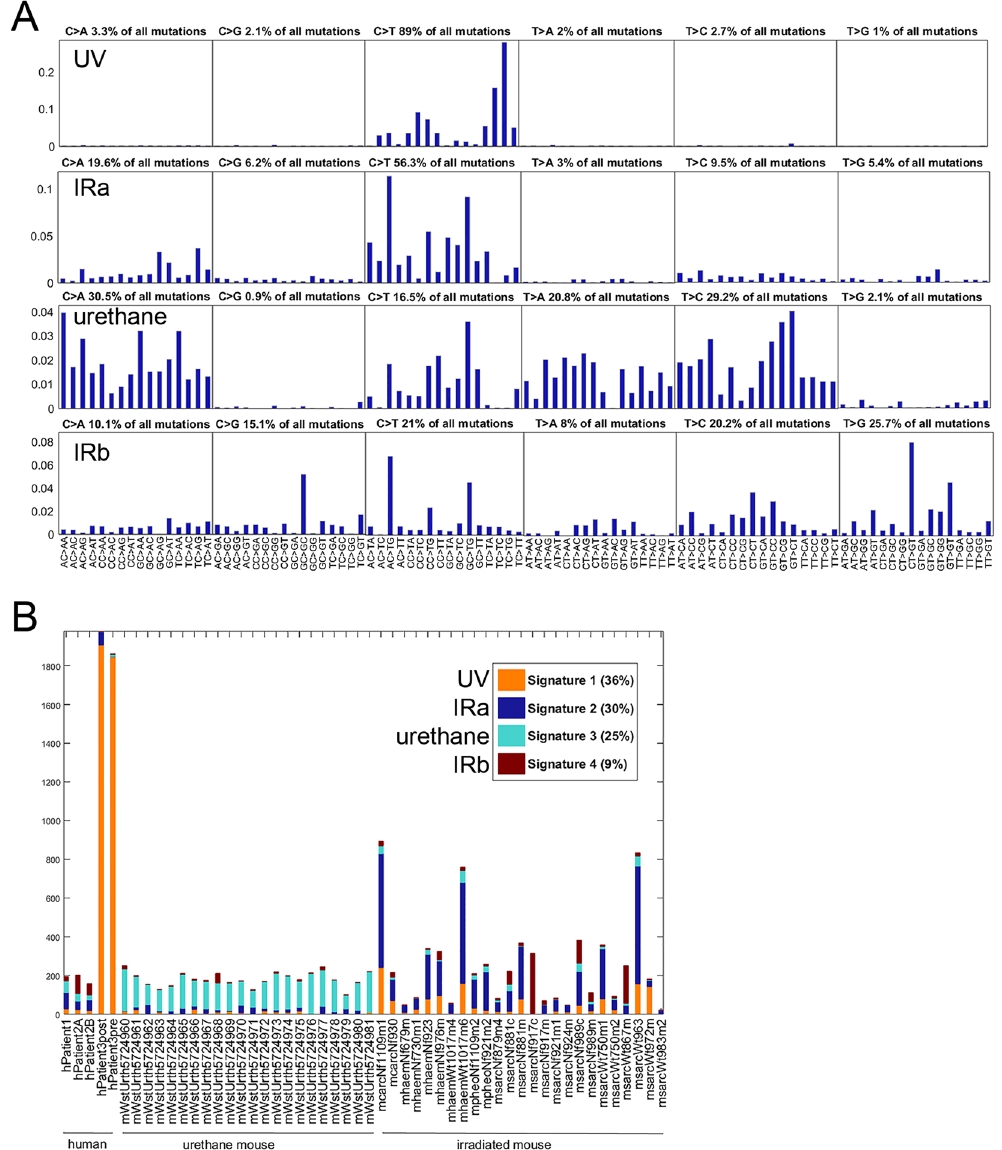
Figure 3. Mutational signatures in human and mouse malignancies induced by IR, UV or chemical mutagenesis. ( A ) The coefficients of 4 signatures from the 52 samples represented in ( A and B ). The majority (56.6%) of mutations represented by Signature 2 are C → T, but as seen in the first analysis, the neighboring bases differ markedly from the neighboring bases contributing to Signature 1, suggesting that the likelihood of C → T mutations to UV versus IR depends on the trinucleotide context. Signatures 3 and 4 are more complex than either of the others. Signature 3 has more C → A (31.2%) than any other type, with T → C, T → A and C → T all fairly prevalent. Signature 4 has approximately equal numbers of C → T, T → C and T → G mutations. ( B ) Shown are the number and proportion of mutations in each signature for each tissue sample when the 5 human tumors from the previous analysis are augmented with data from 25 IR-induced mouse samples and 22 urethane-induced mouse tumors. Signature 1 (UV) is still defined by the 2 samples from the skin cancer patient. However, adding the mouse tumors allows 2 IR signatures and one chemical signature (urethane, Signature 3) to be